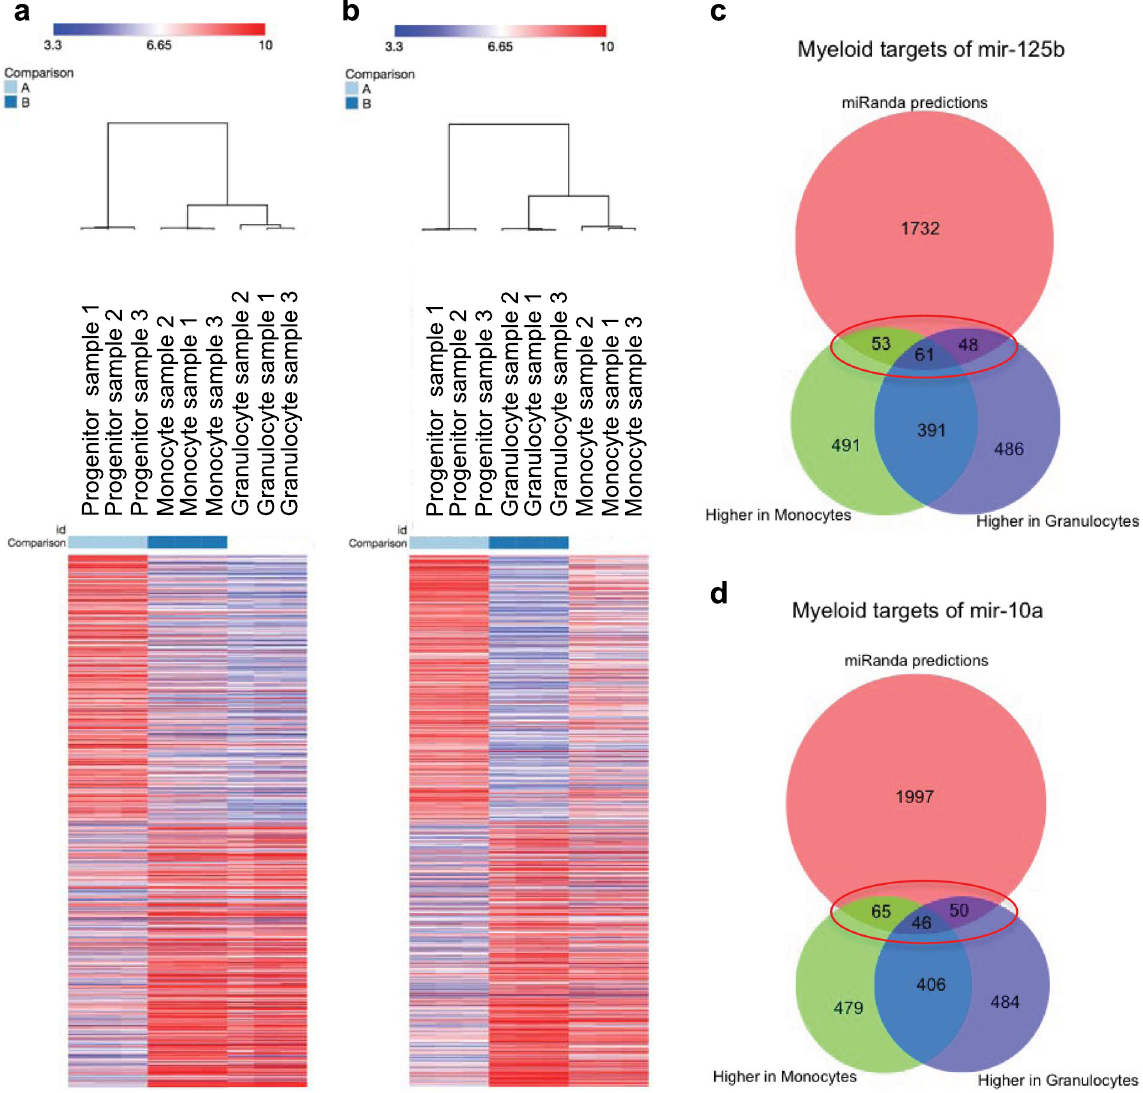
Figure 4. Identifying miRNA targets. Gene expression profiling was performed on progenitors, monocytes and granulocytes isolated from three human cord blood samples (1,2,3) using Affymetrix microarrays. The heatmaps show levels (log 2) of the top 2000 differentially expressed genes between ( a ) progenitors and monocytes and ( b ) progenitors and granulocytes. The identity of transcripts exhibiting higher expression in the mature cell types relative to progenitors was combined with target predictions for miR-125b ( c ) and miR- 10a ( d ), both miRNAs with lower expression in the mature cells. The resulting 162 and 161 genes respectively (circled in red in c and d) that had inverse expression with the miRNA as well as being predicted targets were analysed